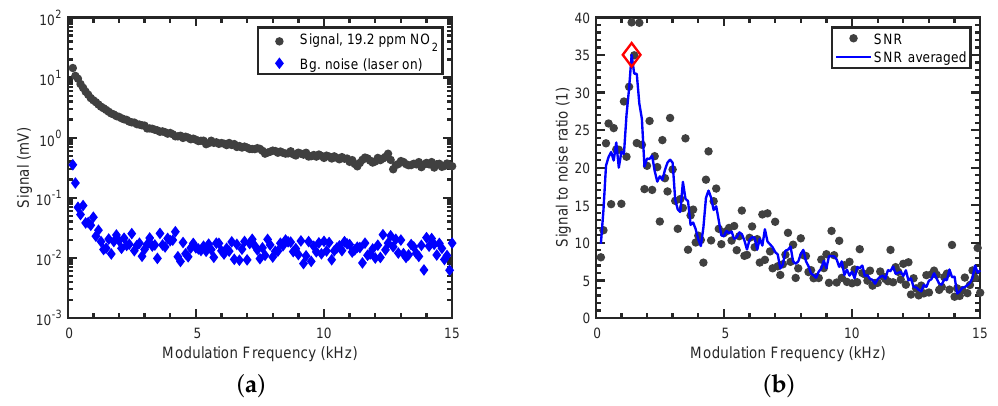
Figure 5. Noise investigations of the PTI sensor: ( a ) Signal with 19.2ppm NO 2 (black circles), background noise for different modulation frequencies with the laser switched on (blue diamonds), measured with lock-in amplifier. Background noise with the laser switched off equals the noise with the modulated laser switched on. ( b ) Signal-to-noise ratio as a function of the modulation frequency. The selected modulation frequency is marked with a red diamond.